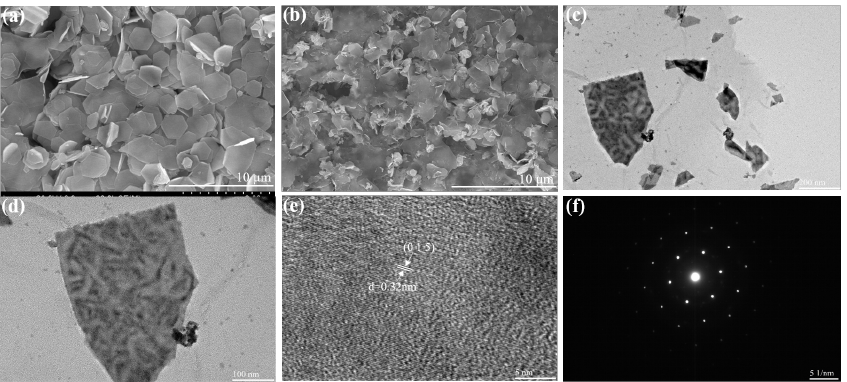
Figure 3. FE-SEM images of ( a ) BT and ( b ) BT/rGO. TEM images of ( c ) BT/rGO and ( d ) BT. ( e ) HRTEM image of BT/rGO. ( f ) SAED pattern of